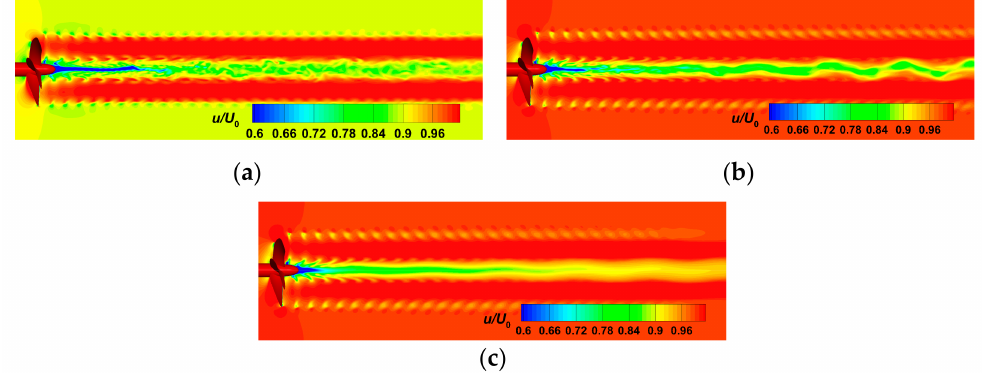
Figure 5. Instantaneous non-dimensional axial velocity fields computed on the longitudinal plane of symmetry: ( a ) J = 0.5, ( b ) J = 0.7, ( c ) J = 1.0.